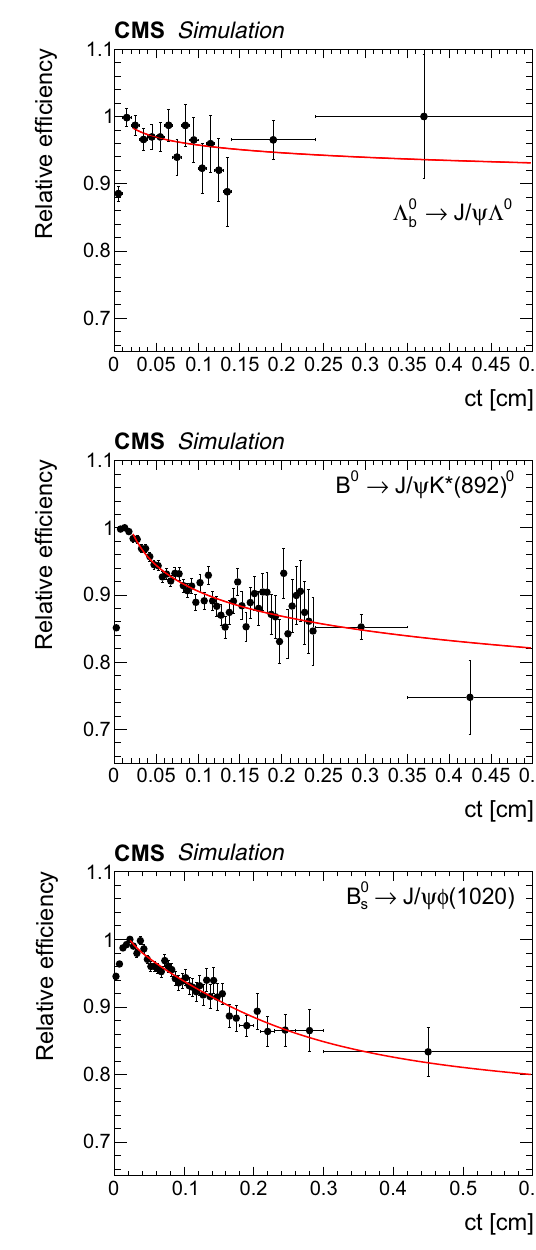
+ − + h decays, where h and 1 2 1